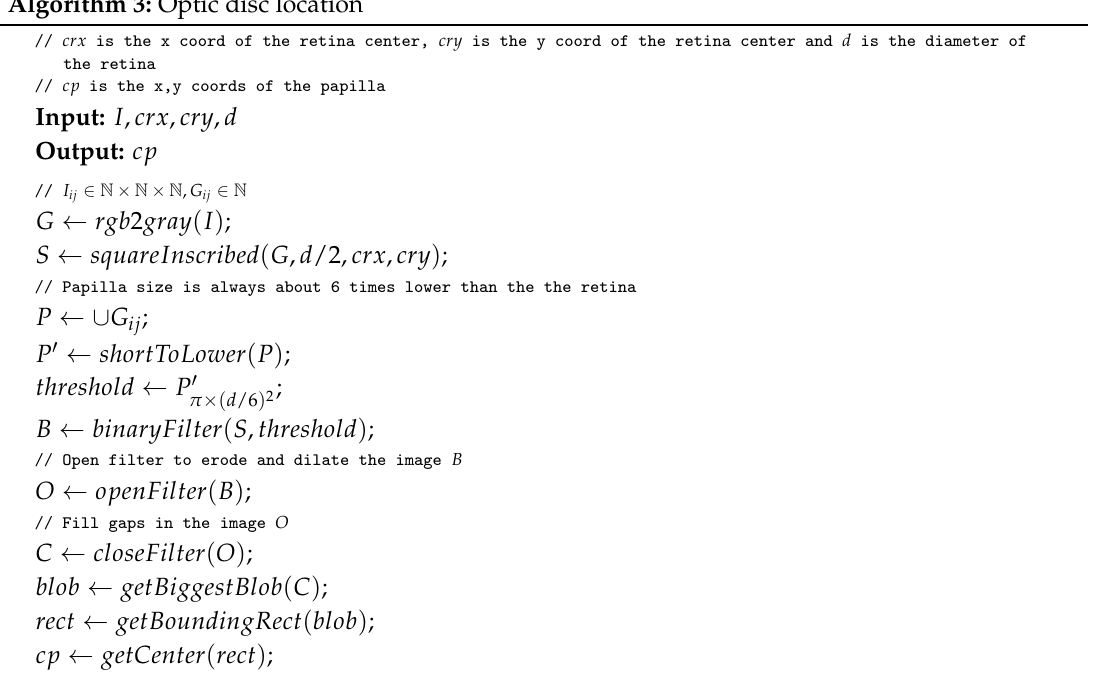
Figure 4. Image processing to locate the optic disc. Algorithm 3: Optic disc